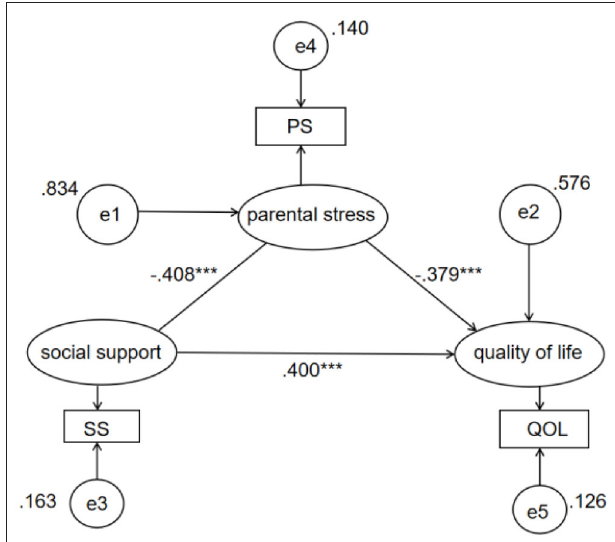
FIGURE 2 | Path analysis of the mediation model.